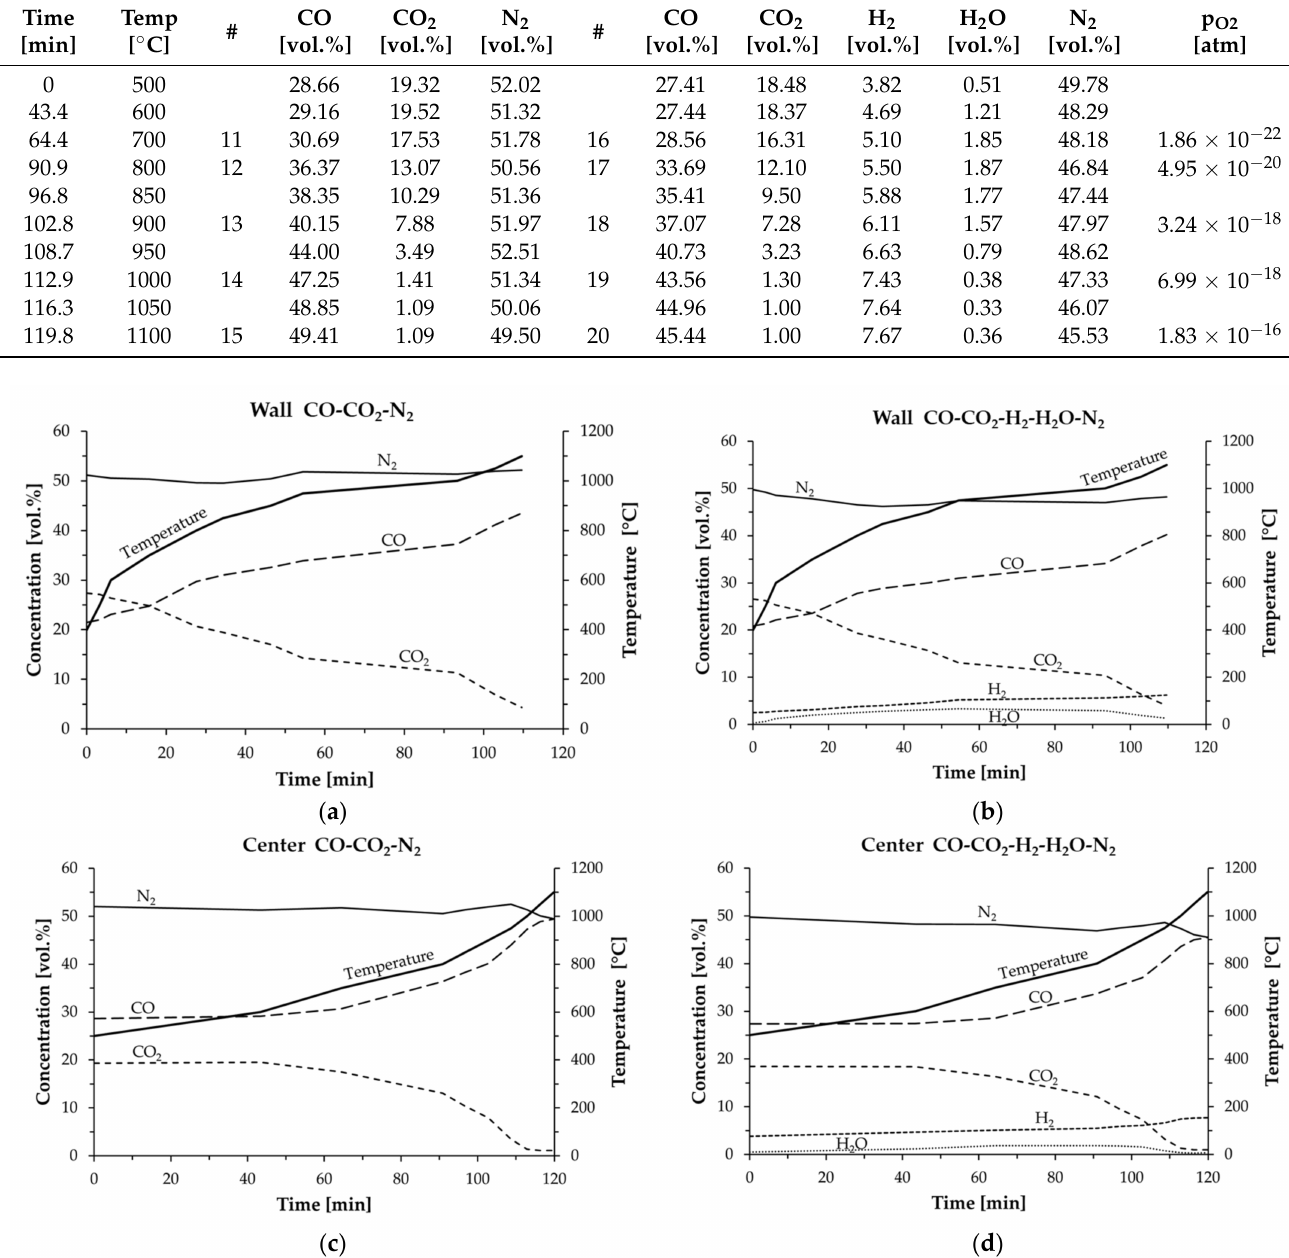
Table 3. Experimental program for the center profile. Time information is cumulative and valid only for non-isothermal tests (numbered 11–20).